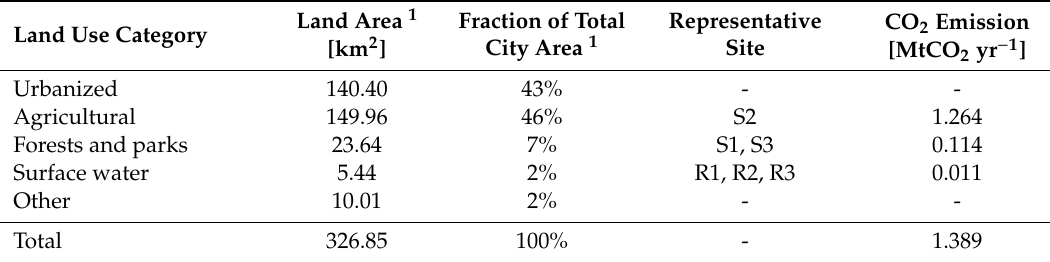
Table 4. Inventory of biogenic CO 2 emissions in Krakow according to land-use